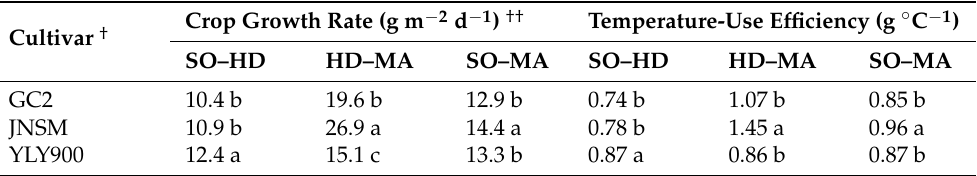
Table 5. Crop growth rate and temperature-use efficiency of three rice cultivars across two years (2019 and